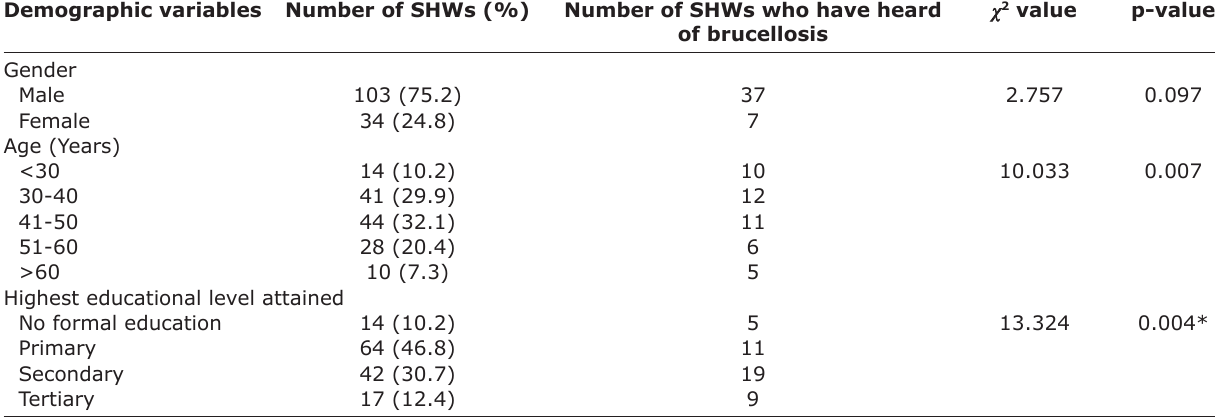
Table-5: Association between awareness of brucellosis, demographics and educational levels of SHWs (n=137) surveyed in Enugu State, Nigeria. Demographic variables Number of SHWs